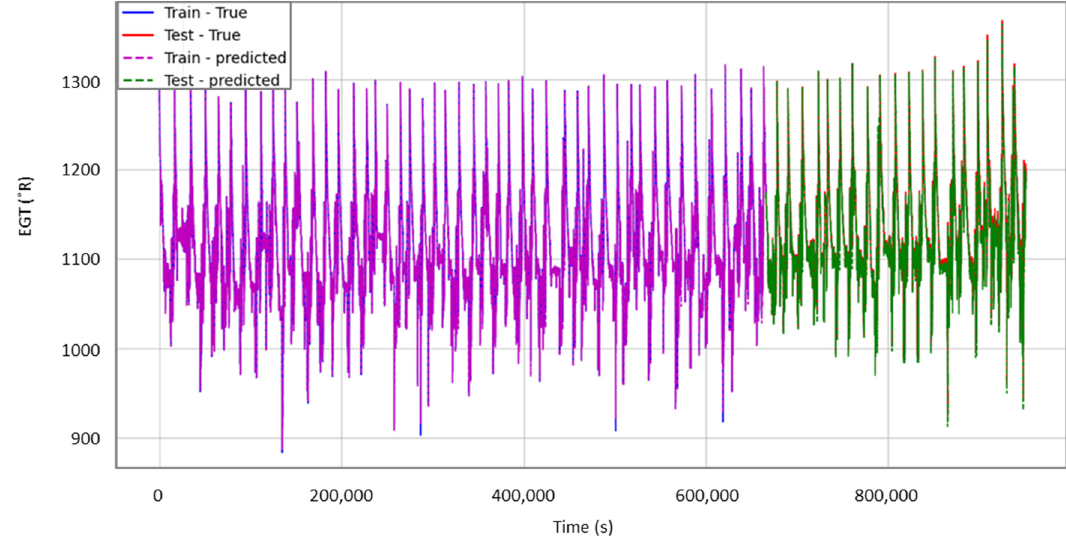
Figure 9. T50 (EGT) prediction for unit 10 of DS03.